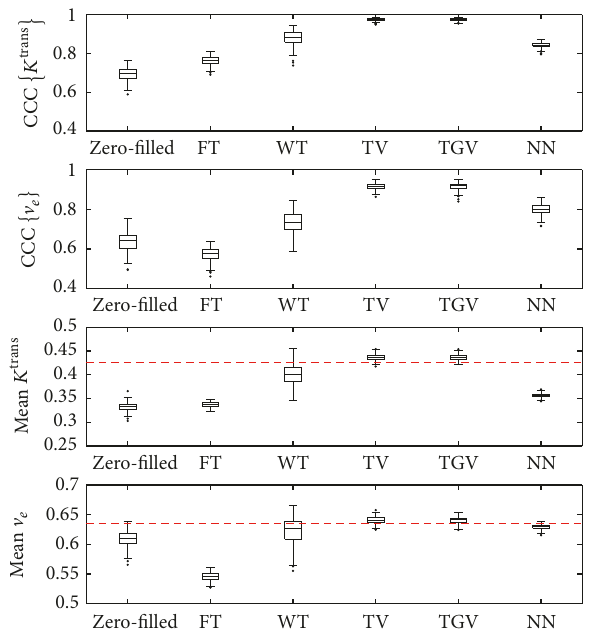
Figure 7: Boxplots of CCCs and tumor means over 200 different sampling patterns. In the first two boxes, the results of the five temporal regularizers are statistically different from each other except the ones between TV and TGV 2 𝛼 . We can observe TV and TGV 2 𝛼 yielded the highest CCCs, which is an illustration of Table 2. In the last two boxes, the red horizontal lines indicate the true tumor mean 𝐾 trans and V 𝑒 , which are 0.425 and 0.635, respectively. Consistent with the results in Table 2, TV and TGV 2 𝛼 produced the most accurate tumor mean 𝐾 trans and V 𝑒 compared to the true values. Interestingly, NN tended to greatly underestimate 𝐾 trans but accurately found V 𝑒 on average with a slight